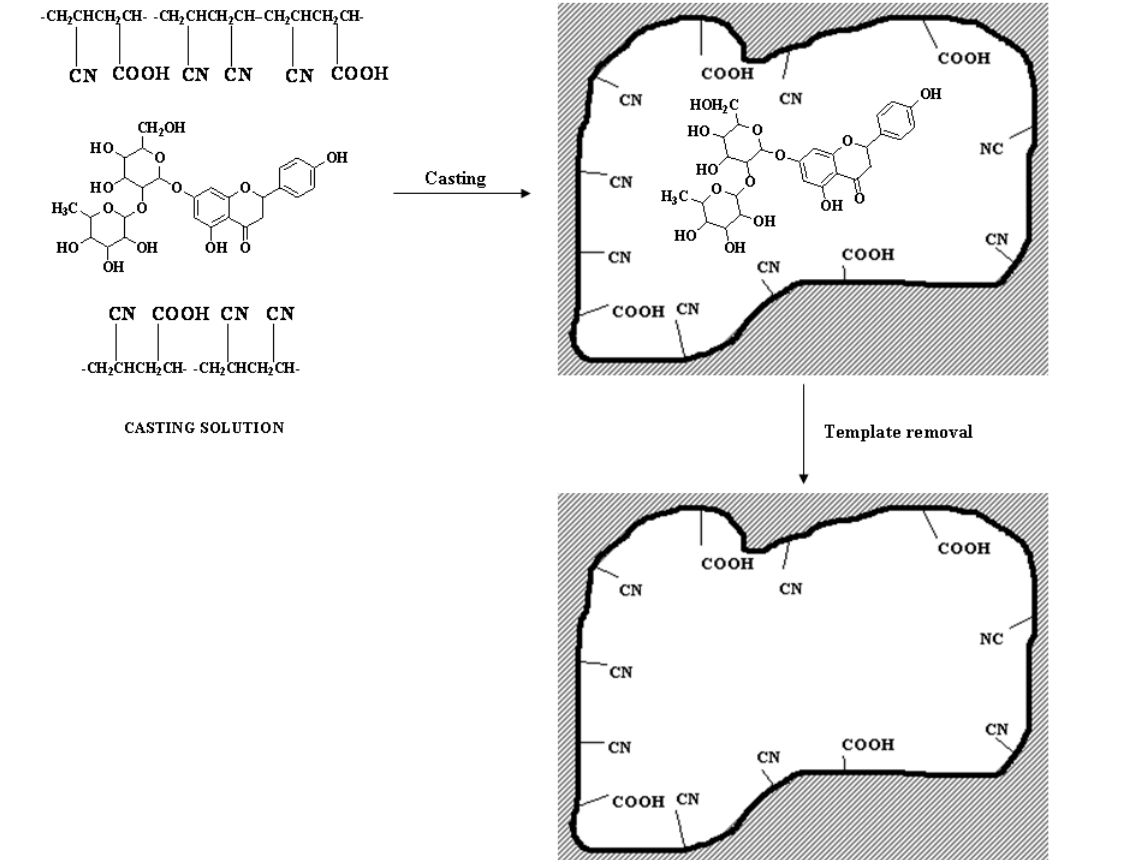
Figure 3. Scheme of NG-MIM